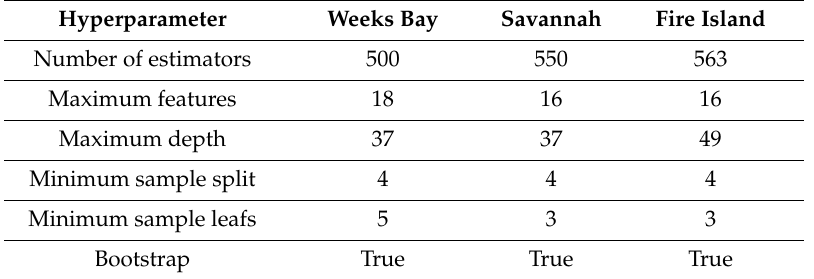
Table 6. Optimal hyperparameters used for land cover classification at each nomenclature level.